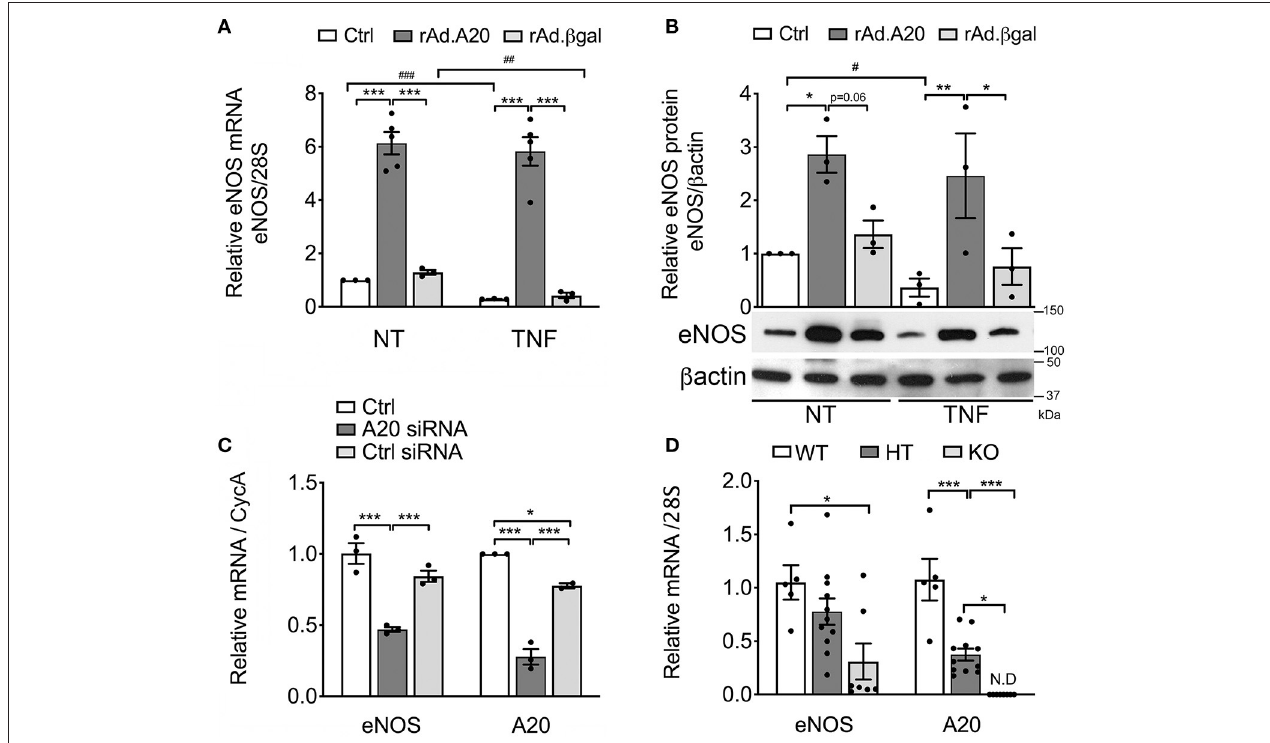
FIGURE 1 | Overexpression of A20 in human coronary artery endothelial cells (HCAEC) increases endothelial nitric oxide synthase (eNOS) expression and prevents its downregulation by TNF, while A20 knockdown decreases eNOS levels. (A) Relative eNOS mRNA (qPCR) normalized by mRNA levels of the housekeeping (HKG) gene 28S and expressed as fold change of non-treated (NT) Ctrl HCAEC, and (B) eNOS protein (WB) levels in non-transduced HCAEC (Ctrl) and in HCAEC transduced with rAd.A20 or control rAd. β gal (100 MOI), before and 24h after treatment with TNF. β -Actin was used to correct for loading. (C) Relative eNOS and A20 mRNA levels (qPCR) in HCAEC non-transfected (Ctrl) and transfected with A20 siRNA or with AllStars negative control siRNA (Ctrl siRNA) for 24h, normalized by the mRNA levels of the HKG gene cyclophilin A (CycA), and expressed as fold change of non-transfected Ctrl HCAEC. All data in (A–C) are presented as mean ± SEM of three to five independent experiments. Significance between groups was determined by one- or two-way ANOVA followed by the Tukey or Bonferroni multiple comparison post hoc test, respectively; * p < 0.05, ** p < 0.01, *** p < 0.001. Significance between NT and TNF-treated HCAEC was determined by an unpaired t test and depicted as hashtag in lieu of asterisk symbols in order to better differentiate between the two statistical methods used to analyze the data. # p < 0.05, ## p < 0.01, ### p < 0.001. (D) Relative eNOS and A20 mRNA levels in the aortae of 3–4-week-old A20 knockout (KO) and heterozygous (HT) mice, as well as wild-type (WT) littermates. Data are presented as mean ± SEM of 5–11 animals/group. Significance between groups was determined by one-way ANOVA followed by the Tukey multiple comparison post hoc test; * p < 0.05, ** p < 0.01, *** p < 0.001. (E) Representative eNOS immunohistochemistry (brown) in the brain of A20 wild-type (WT), heterozygous (HT), and knockout (KO) mice. Photomicrographs are representative of three animals per genotype, magnification = ×